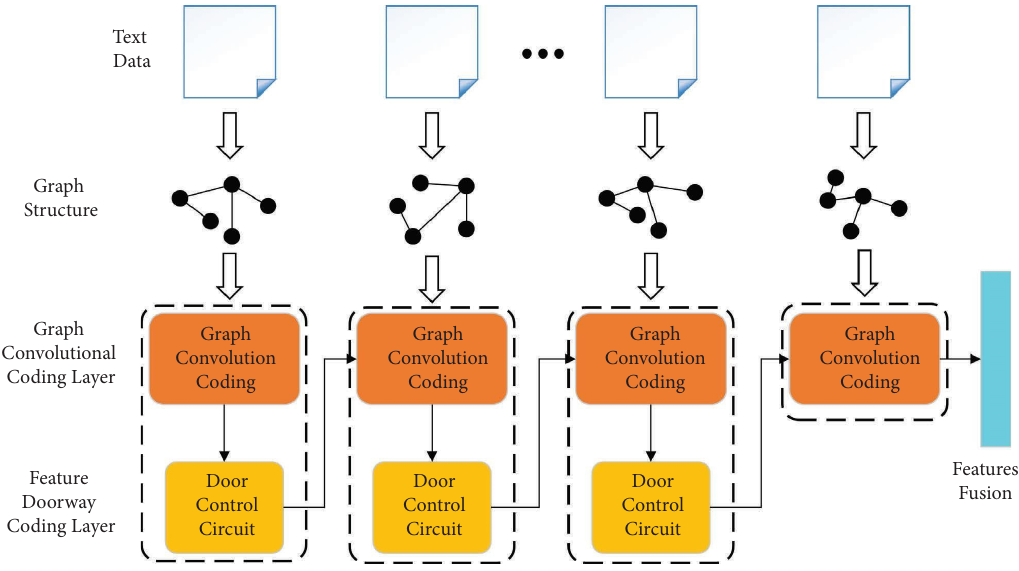
Figure 2: Feature extraction model of text